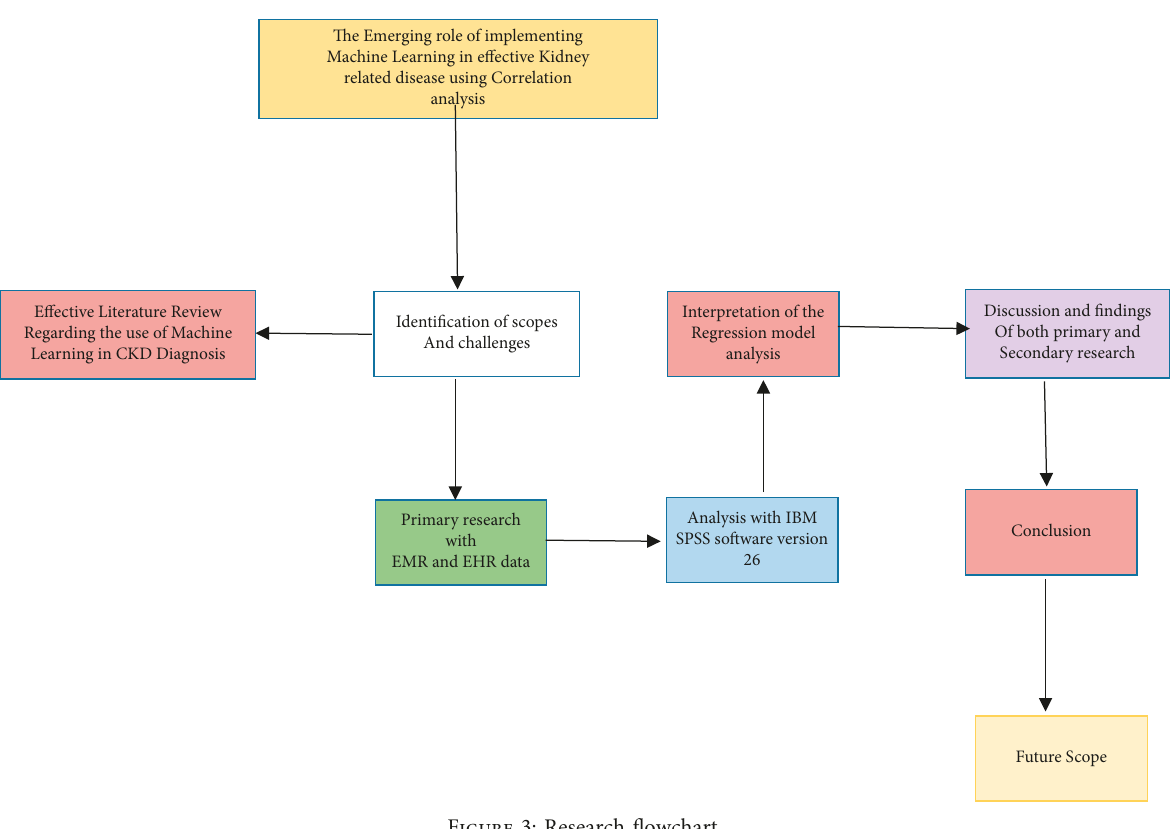
Figure 3: Research